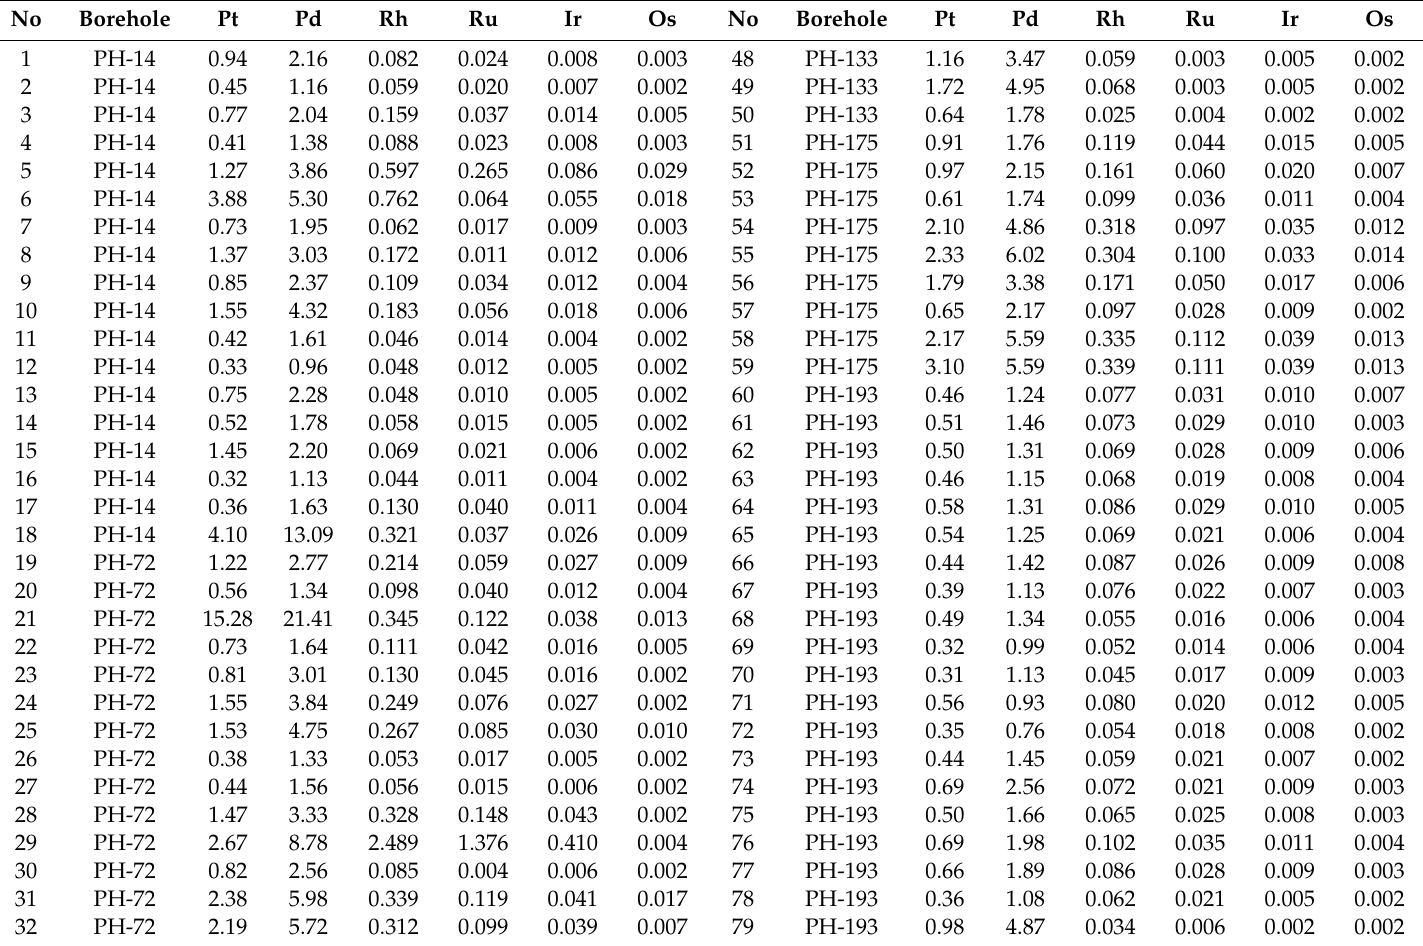
Table 4. Compositions of rocks (with refractory PGE) of sample samples from core